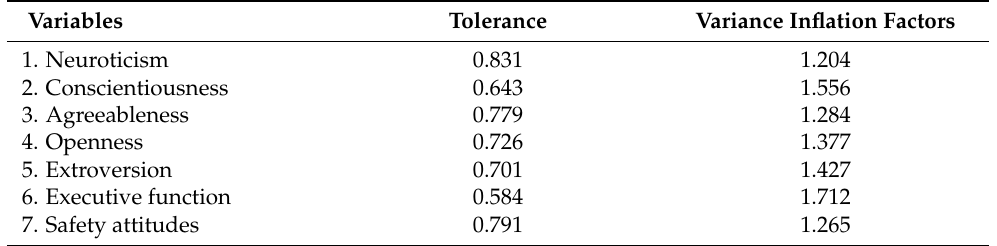
Table 4. Multicollinearity analysis of variables.